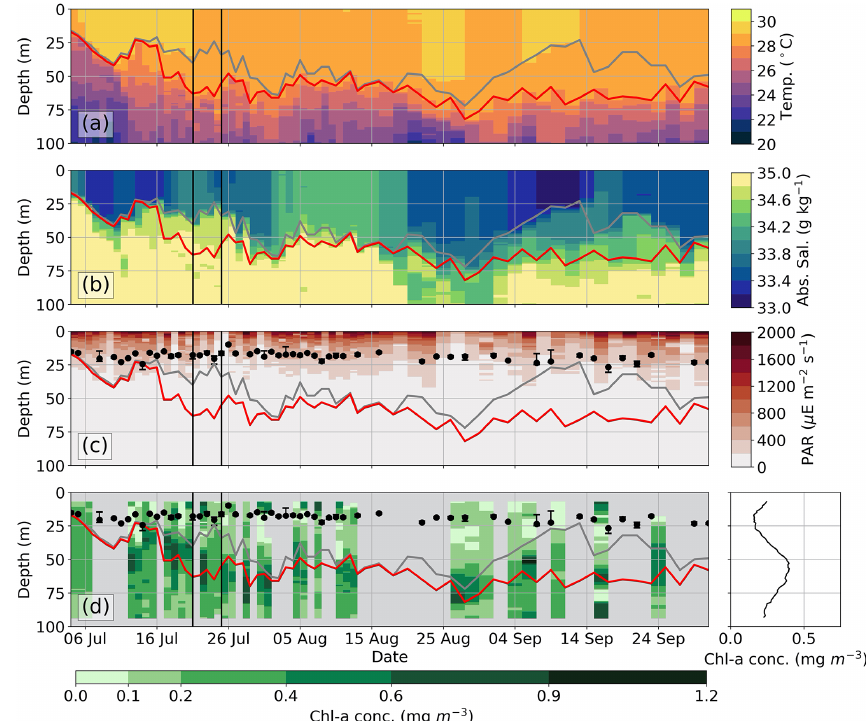
Figure 6. Time series of observations measured by float 631, linearly interpolated to 1m depth intervals: (a) temperature ( ◦ C), (b) absolute salinity (gkg − 1 ), (c) PAR µEm − 2 s − 1 , and (d) chlorophyll concentration with the vertical profile of the average chlorophyll concentration (mgm − 3 ). Grey sections in the chlorophyll time series represent removed E d (490) profiles that displayed excessive noise. The black dots are scale depth values, h 2 (m). The region between the MLD (grey line) and isothermal layer depth (red line) is the barrier